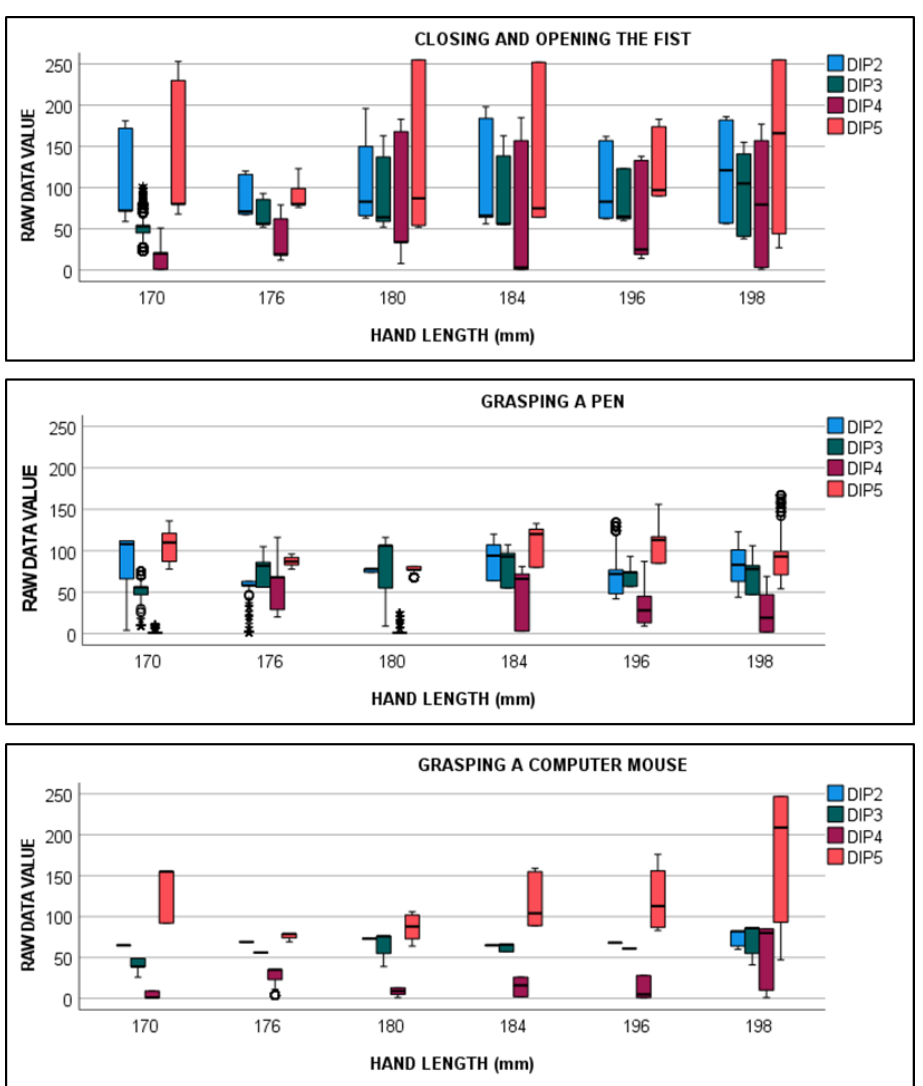
Figure 7. Raw data recorded during the three motion tasks for each hand length. Color legend: index finger DIP (DIP2) in blue, middle finger DIP (DIP3) in green, ring finger DIP (DIP4) in red, and little finger DIP (DIP5) in orange.